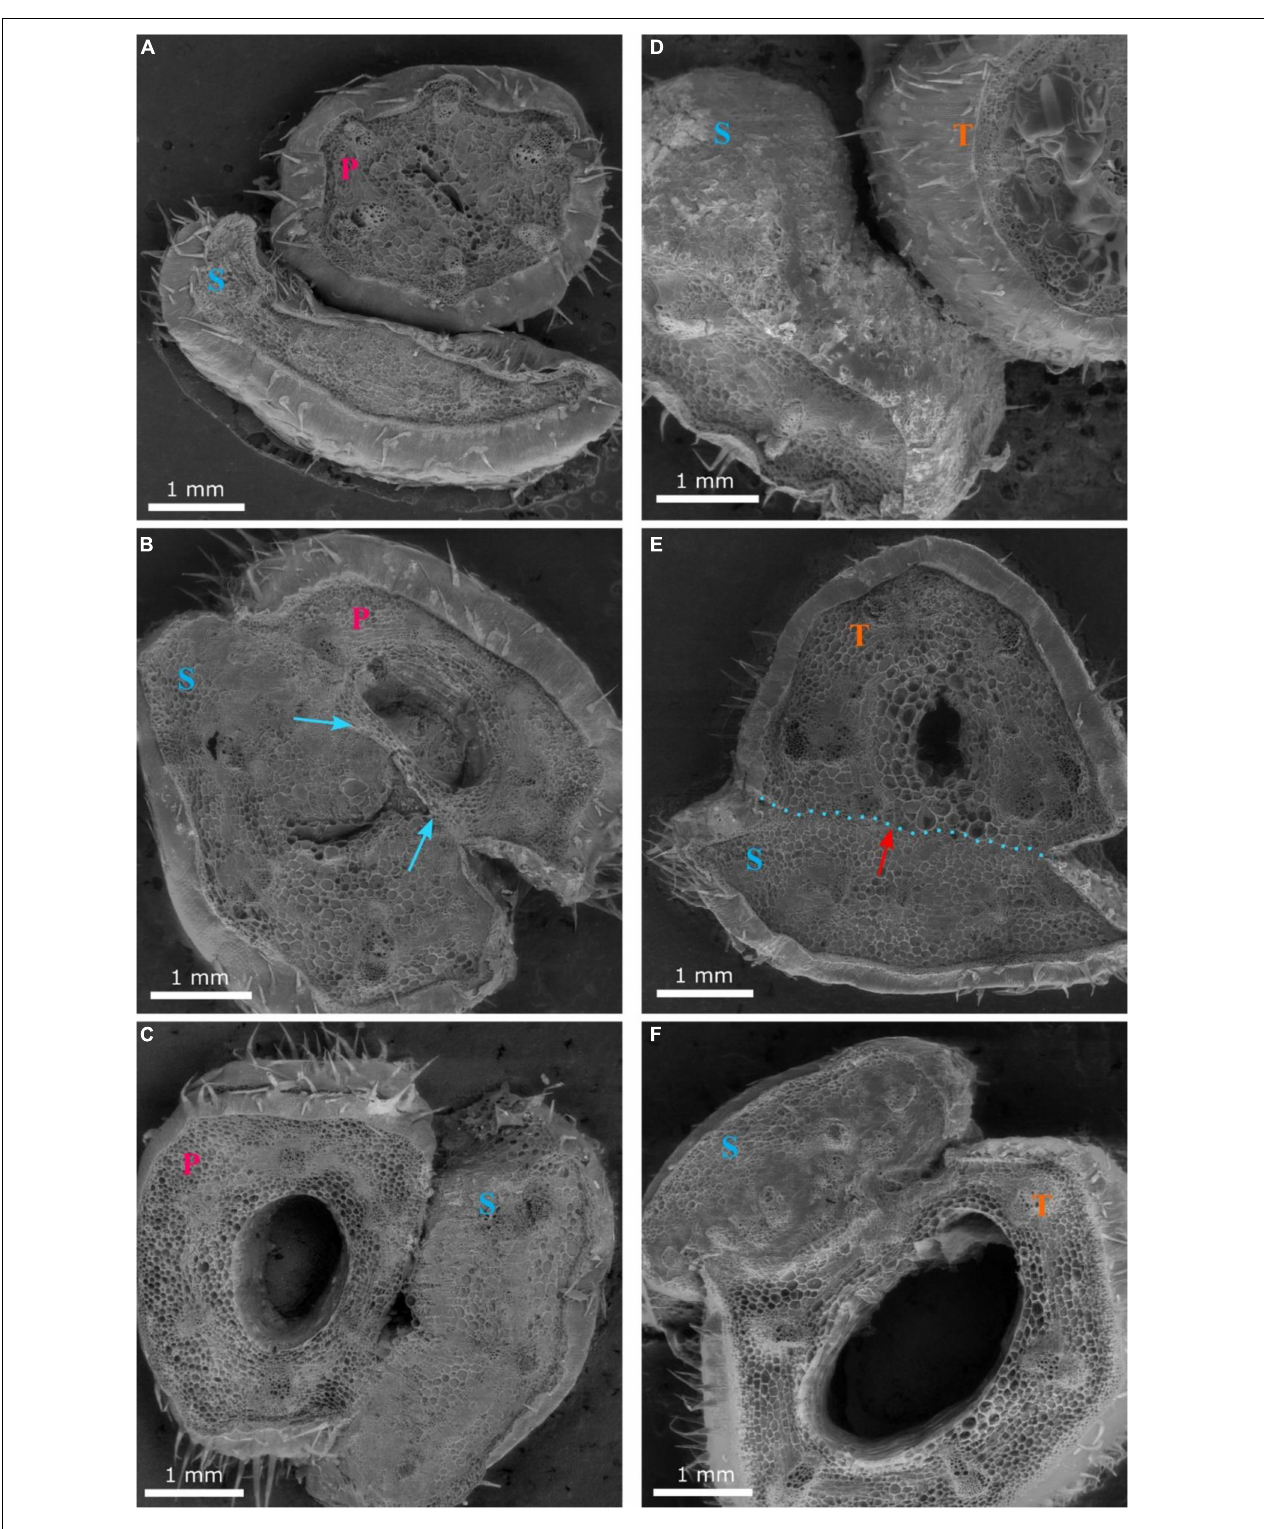
FIGURE 4 | Cross-sections 1 (A,D) , 2 (B,E) and 3 (C,F) of the graft union between watermelon cultivar ‘Secretariat’ (S) and rootstocks ‘Pelop’ (P; A–C ) and ‘Tetsukabuto’ (T; D–F ) at 11 days after grafting; where cross-sections were: (1) top of the graft union, (2) centered through the graft union, and (3) bottom of the graft union. The blue arrow (B) indicates dead parenchymatic cells at the pith center and a necrotic layer. The red arrow with blue dotted line (E) indicates new xylem strands are formed in the vascular system and connect the rootstock with the scion.